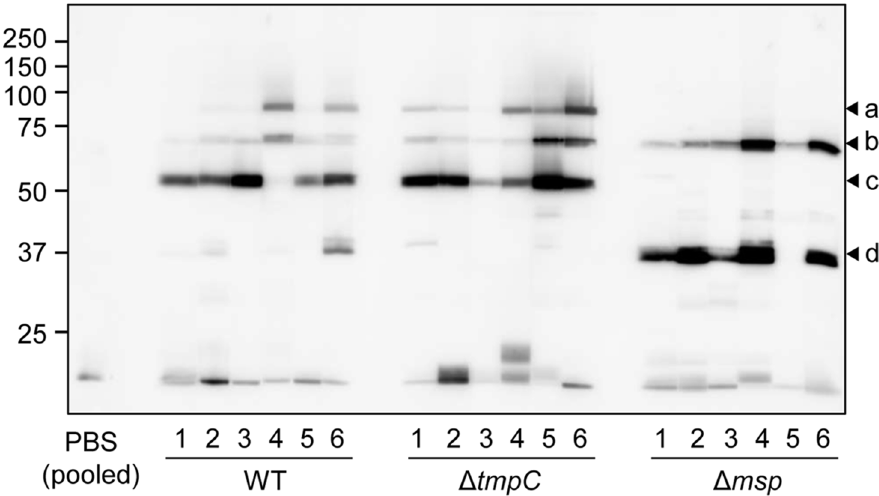
Figure 9. Reactivity of sera of mice injected with T . denticola strains to cellular components of T . denticola . The whole-cell lysate of wild- type T . denticola was applied to SDS-PAGE (11% gel) and blotted on a PVDF membrane. The PVDF membrane was cut into strips and reacted with each serum sample collected at 3 weeks after injection. As a negative control, sera of mice injected with PBS were pooled and subjected to immunoreaction. Numbers denote individual mice. Major bands were indicated by a, b, c, and d and were predicted to react to TDE1072, OppA, Msp, and TmpC, respectively. A molecular-weight standard (kDa) is shown at the left.